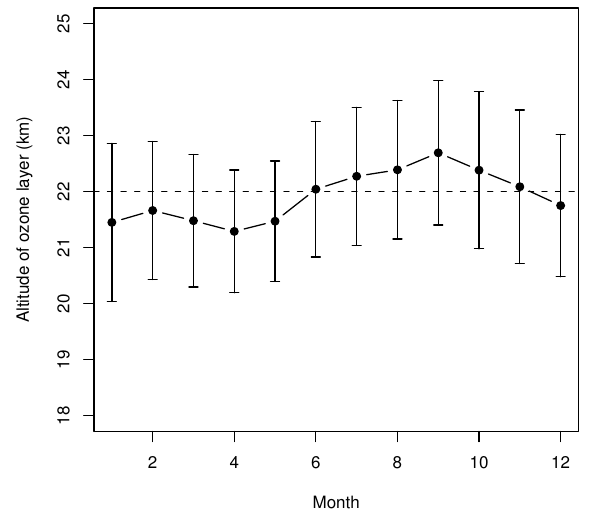
Fig. 3. Relative differences between the approximated ozone air mass factor (AMF) by the Brewer algorithm using five altitudes for the ozone layer (18, 20, 22, 24, 26km) and the simulated ozone AMF using the average ozone profile in June as a function of the solar zenith